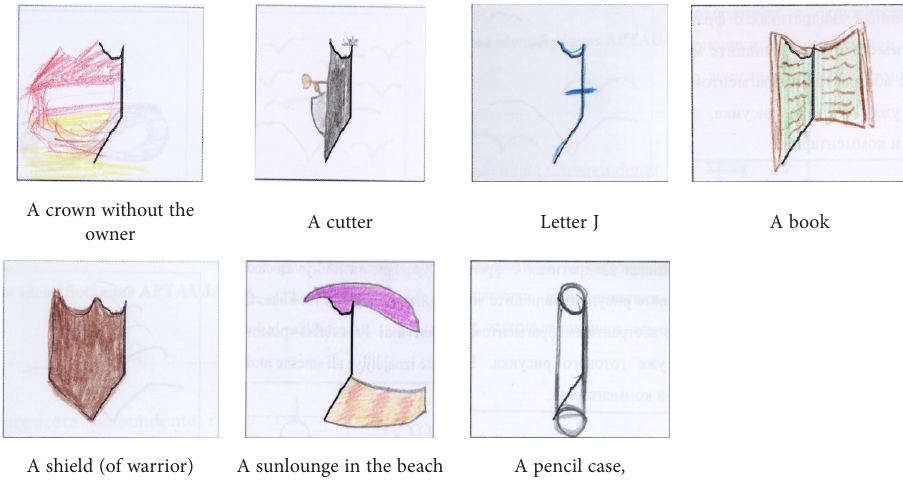
Figure 33. The creative task: interpretation of Fragment 5 – exceptional images (source: testingmom.com, 2020) The following objects were found among exceptional interpreted images: a cutter as a means of transportation (Lithuania), a book and a warrior’s shield (Latvia), a sunlounger with an umbrella (Slovenia) and a stationery item: a pencil tube (Belarus) (Figure 33). Research participants from Estonia did not provide any exceptional interpretations of this